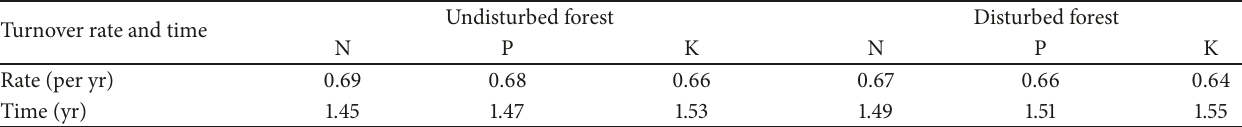
Table 12: Turnoverrate( k ) and turnover time ( t ) of litter nutrients on forest floor in undisturbed and disturbed stands of moist tropical forest in Sunsari district, eastern Nepal.